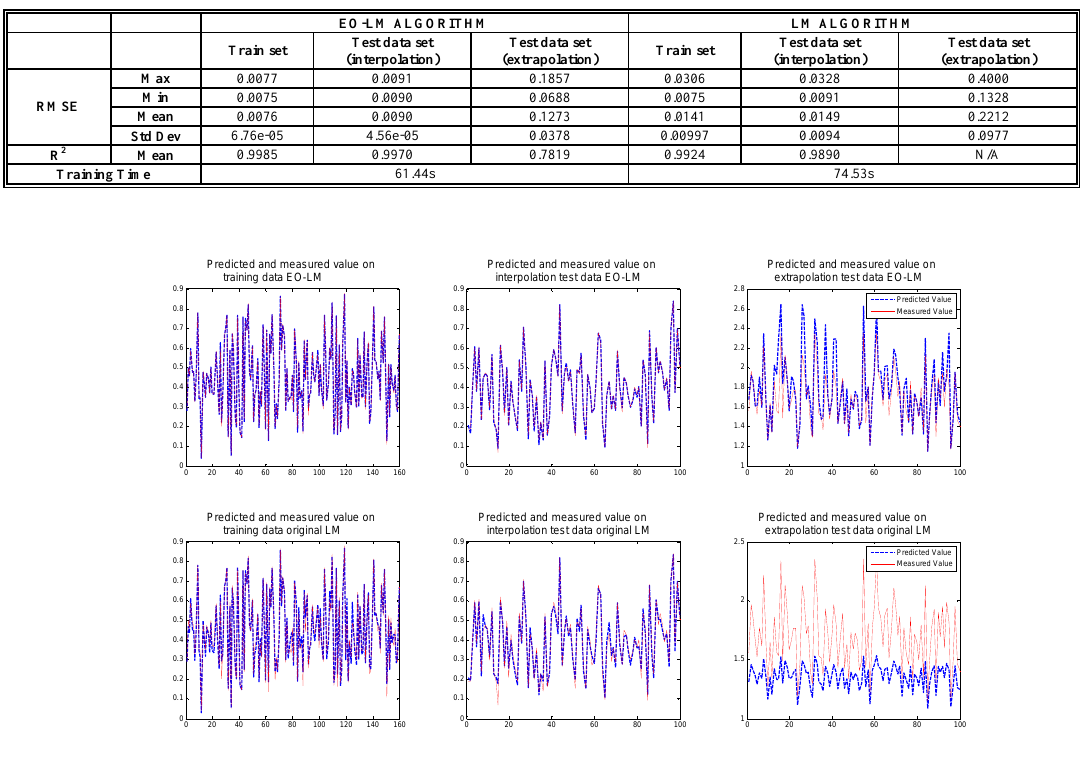
Fig. 4. The performance comparison between EO-LM and LM on train/ interpolation test/ extrapolation test